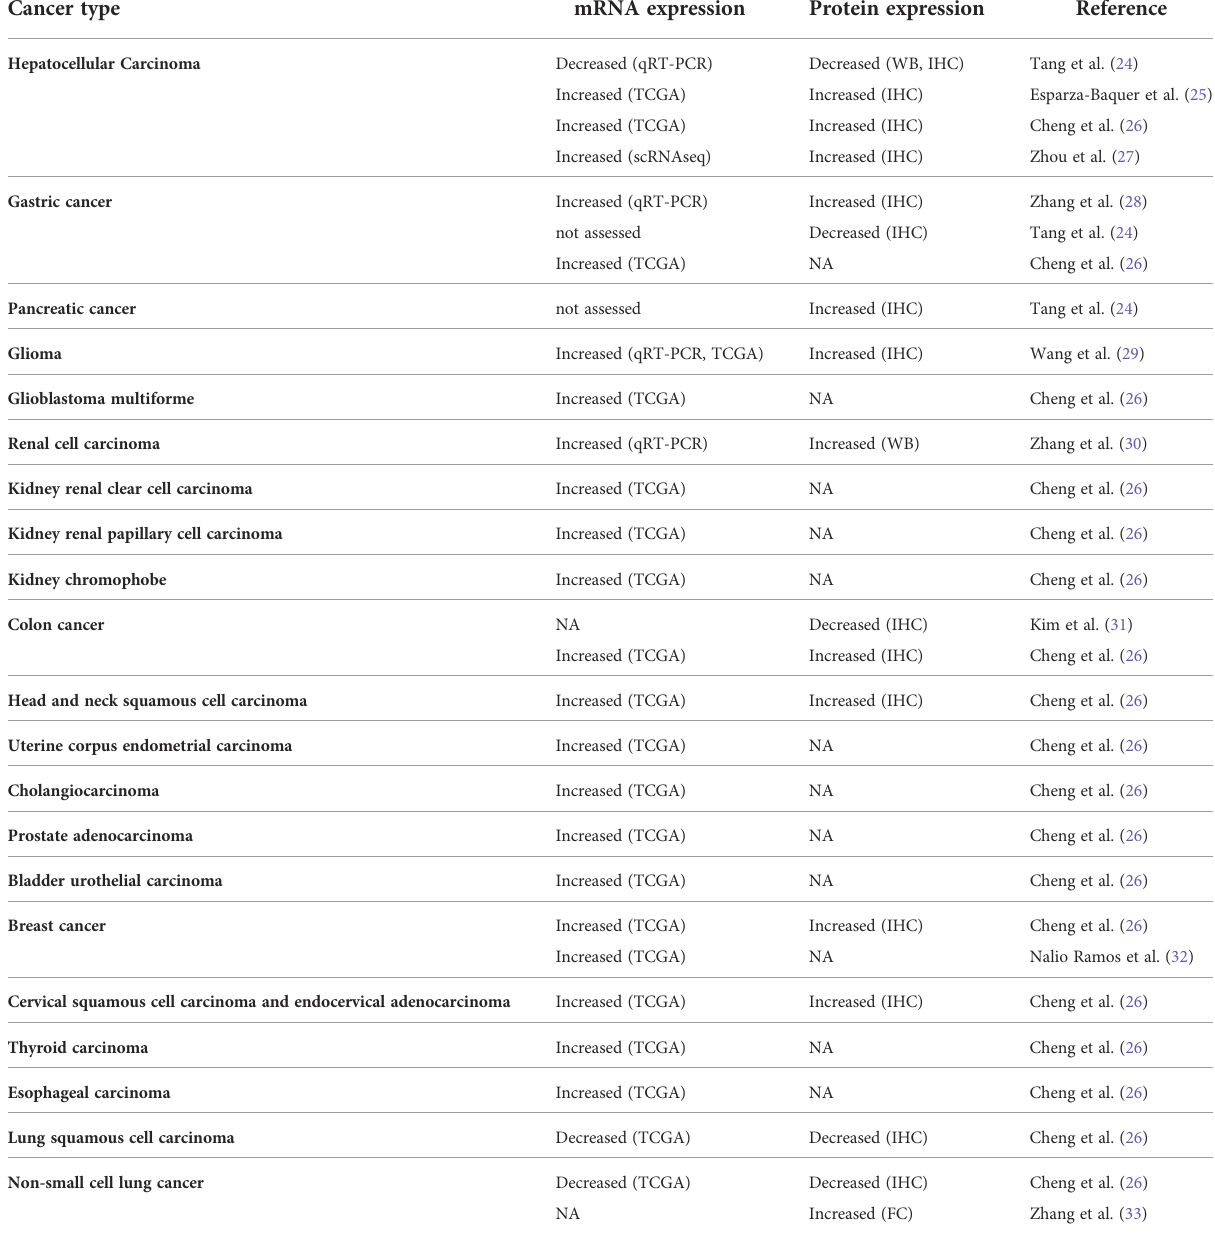
TABLE 1 TREM2 expression in human